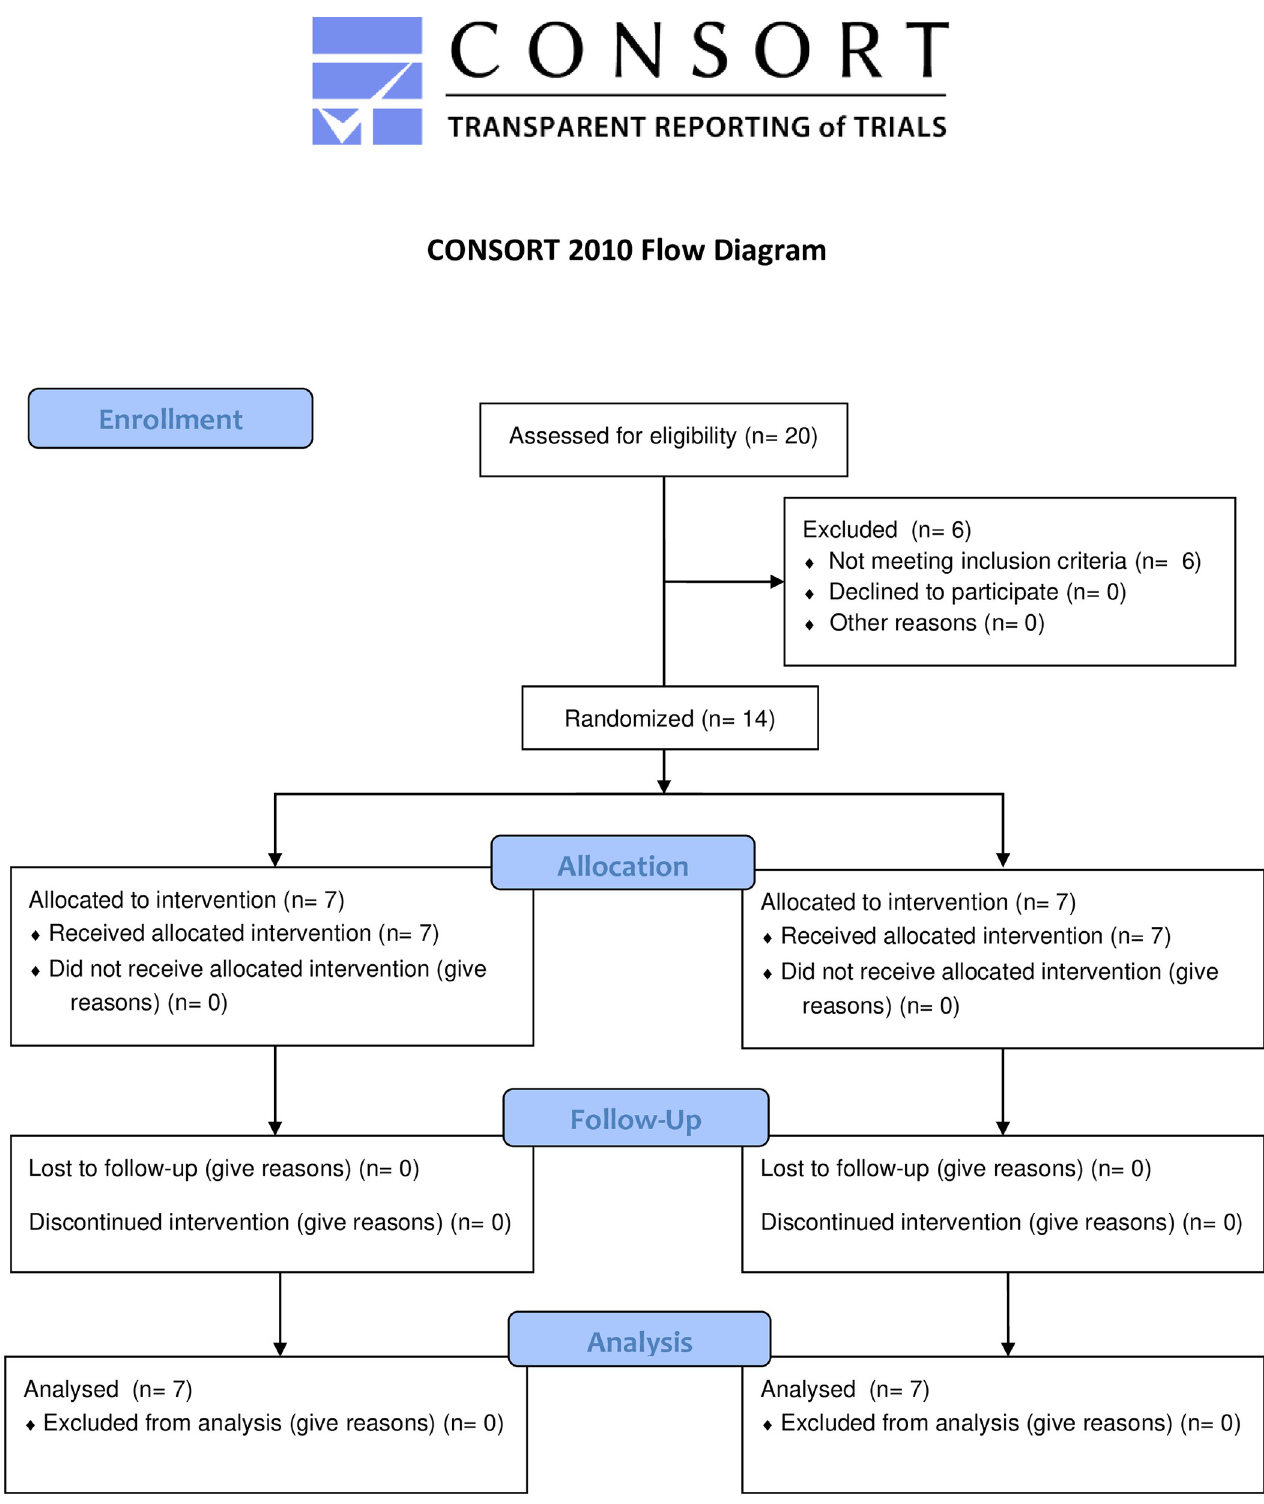
Fig 1. Trial design. All participants underwent randomisation and were allocated to either the placebo or testosterone arm.